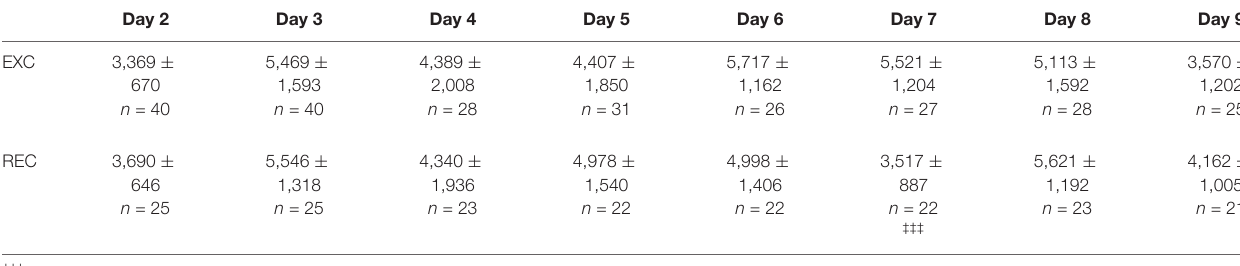
TABLE 2 | Mean ± SD daily values of energy expenditure (kcal/d) in the exercise (EXC) and recovery (REC) groups.